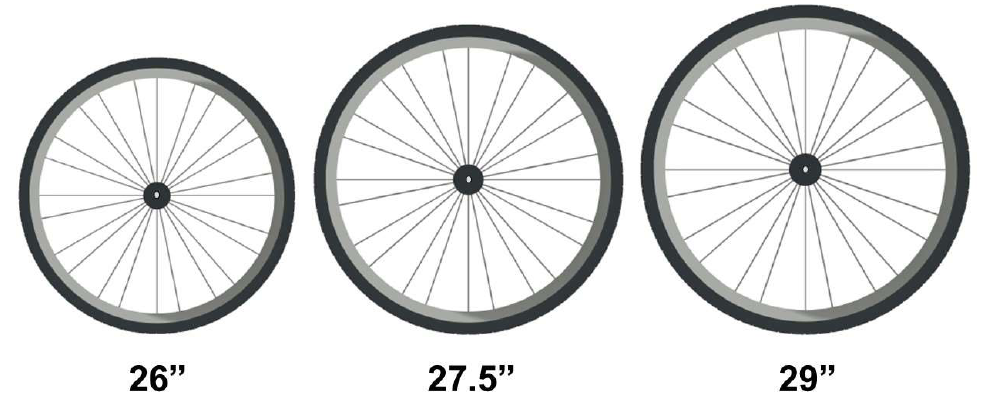
Figure 10. Example of the bike wheel diameters for XC throughout the years.